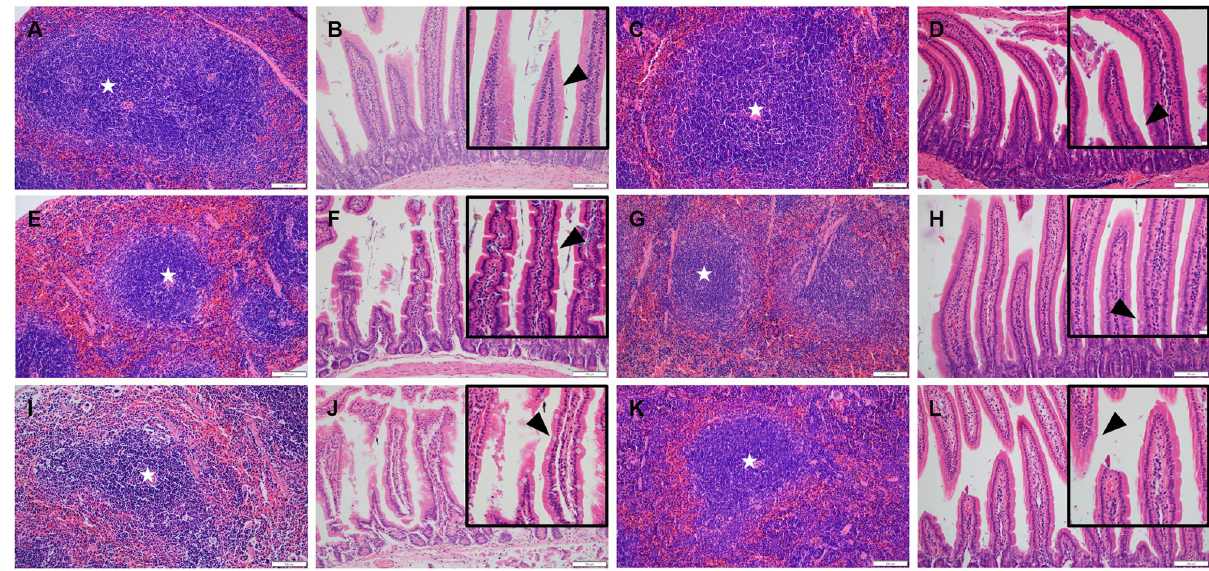
Fig 7. Histopathological analysis of spleens, and small intestines of SARS-CoV-2 infected K18-hACE2 and CAG-hACE2 transgenic mice. Spleen and small intestine sections of a K18-hACE2 mouse of the NC group (A, B), VL group (E, F), VH group (I, J) and a CAG-hACE2 mouse of the NC group (C, D), VL group (G, H), VH group (K, L) on 5 dpi. White pulp in spleen (star); goblet cell in small intestine (arrowhead); (magnification x200, inset x400).